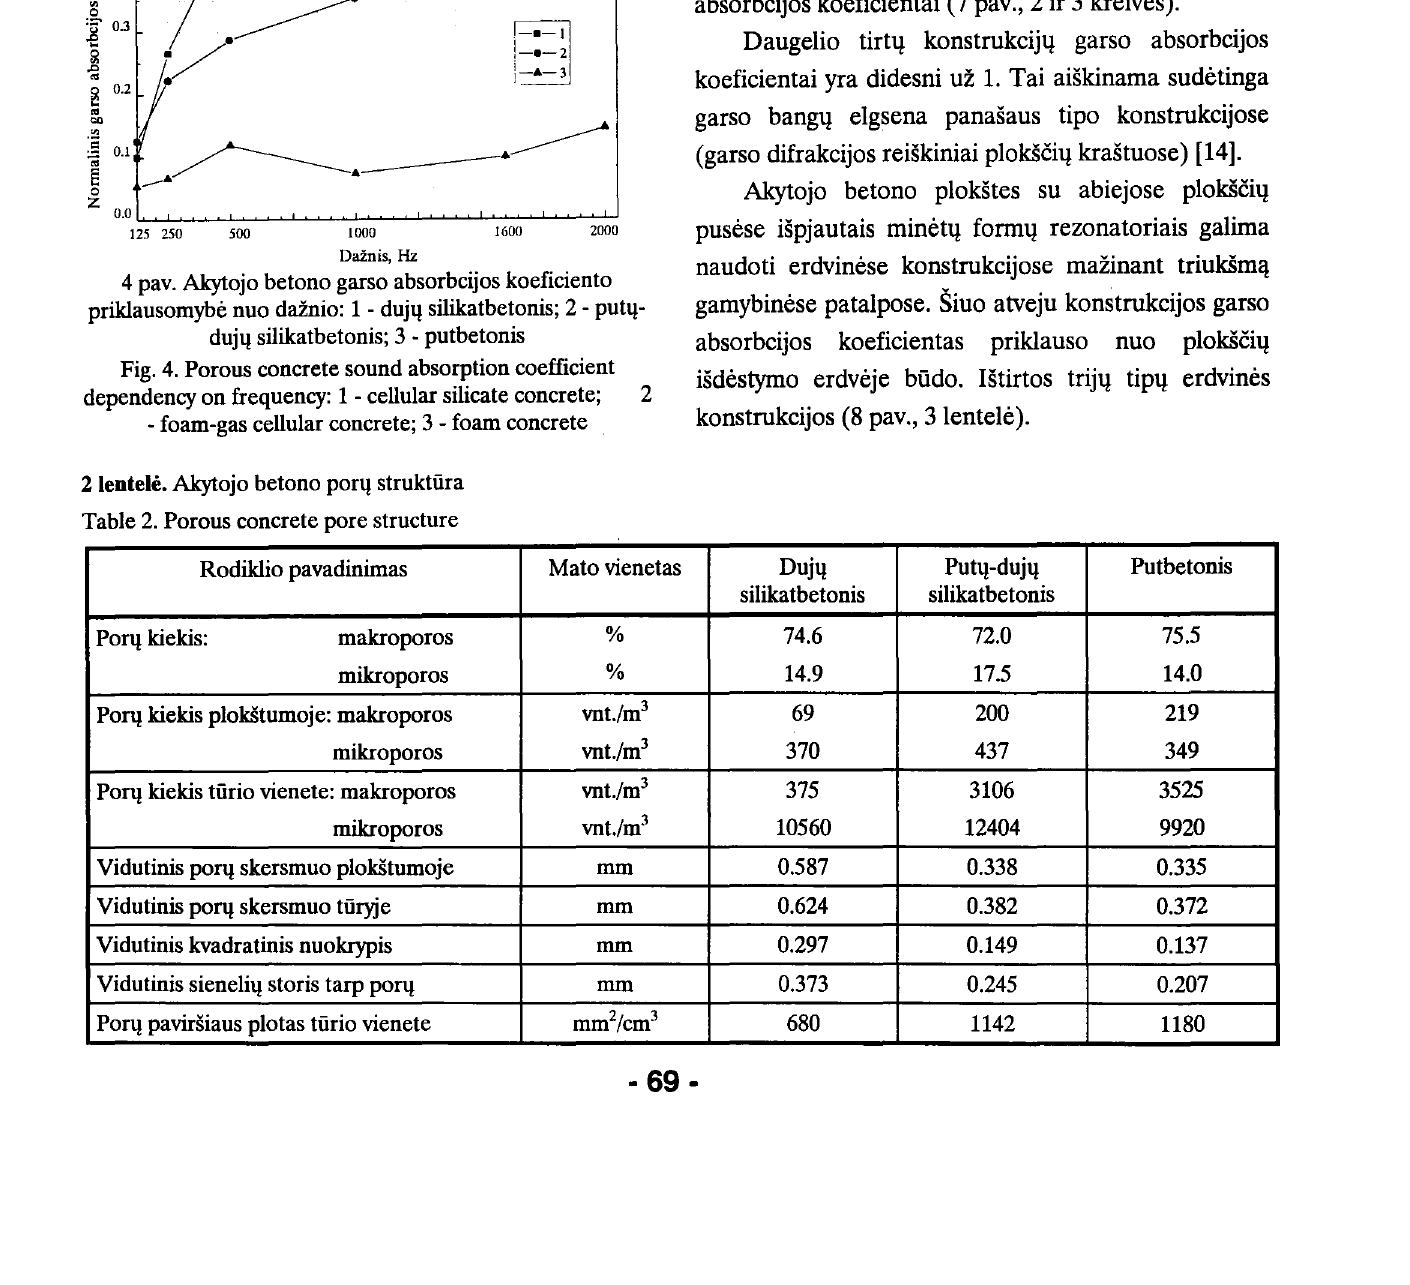
Fig. 5. Distribution of pores in porous concrete: 1 -foam concrete; 2 - foam-gas silicate concrete; 3 - gas silicate concrete Del ispjovq akytojo betono plokStese mazeja plokSciq pavirsiaus akustine varza, todei dideja garso absorbcijos koeficientai (7 pav., 2 ir 3